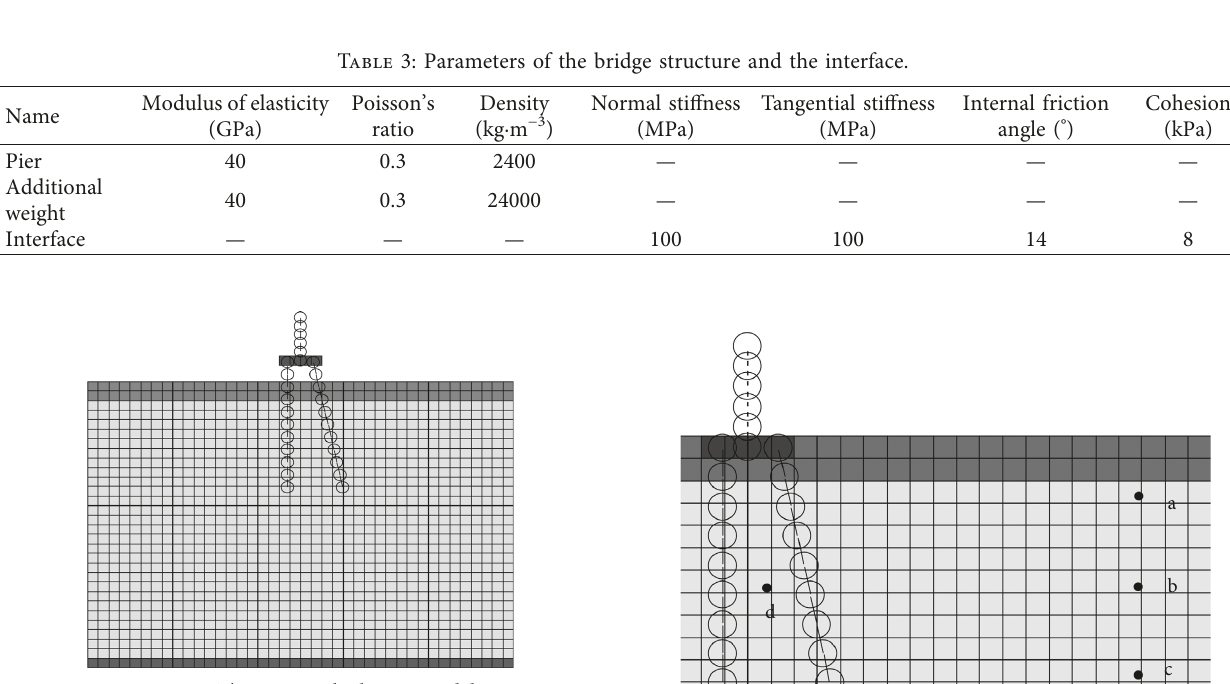
Figure 7: The static calculation model.